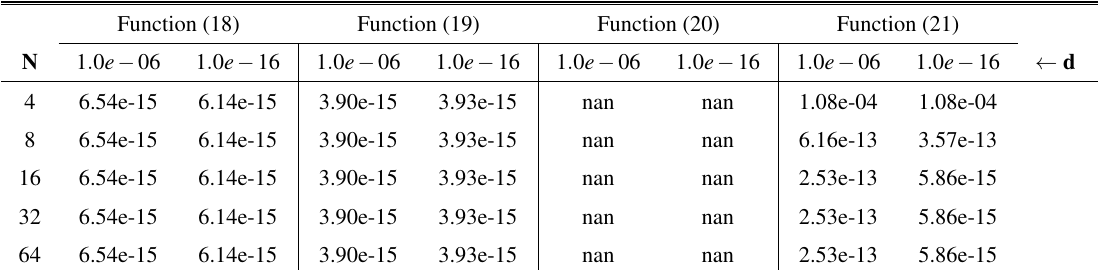
Table 4 C || e r || L